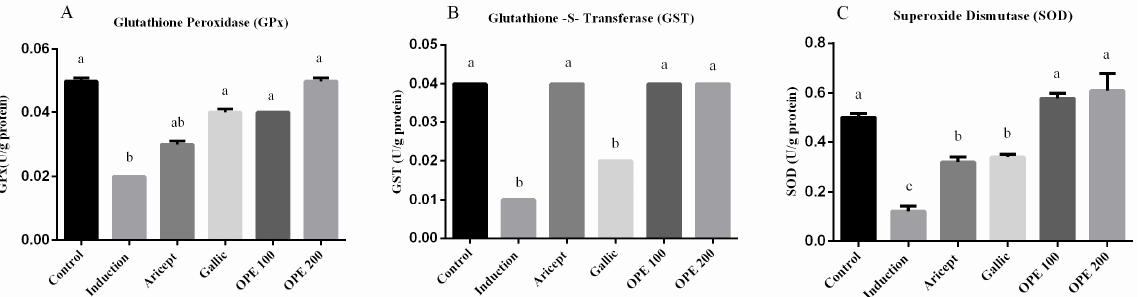
Figure 2. Effect of Aricept, gallic, OPE 100, and OPE 200 on brain antioxidant enzymes. Glutathione peroxidase (GPx) ( A ), Glutathione-S-transferase (GST) ( B ) and superoxide dismutase (SOD) ( C ) ac- tivities. Values represent the mean ± SD of six rats. ANOVA (one-way) followed by Tukey’s test. Values bearing the same letters showed no significant difference ( p < 0.05). The results are sorted in p < 0.05). The results are sorted in descending order: a < b < c. Values bearing the same letters showed no significant difference ( descending order: a < b <